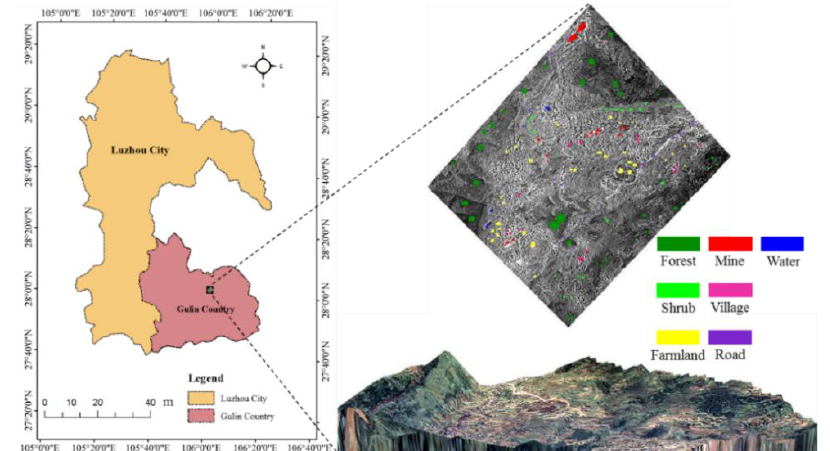
Figure 1. Location of study area, training samples and 3D representation of remote sensing